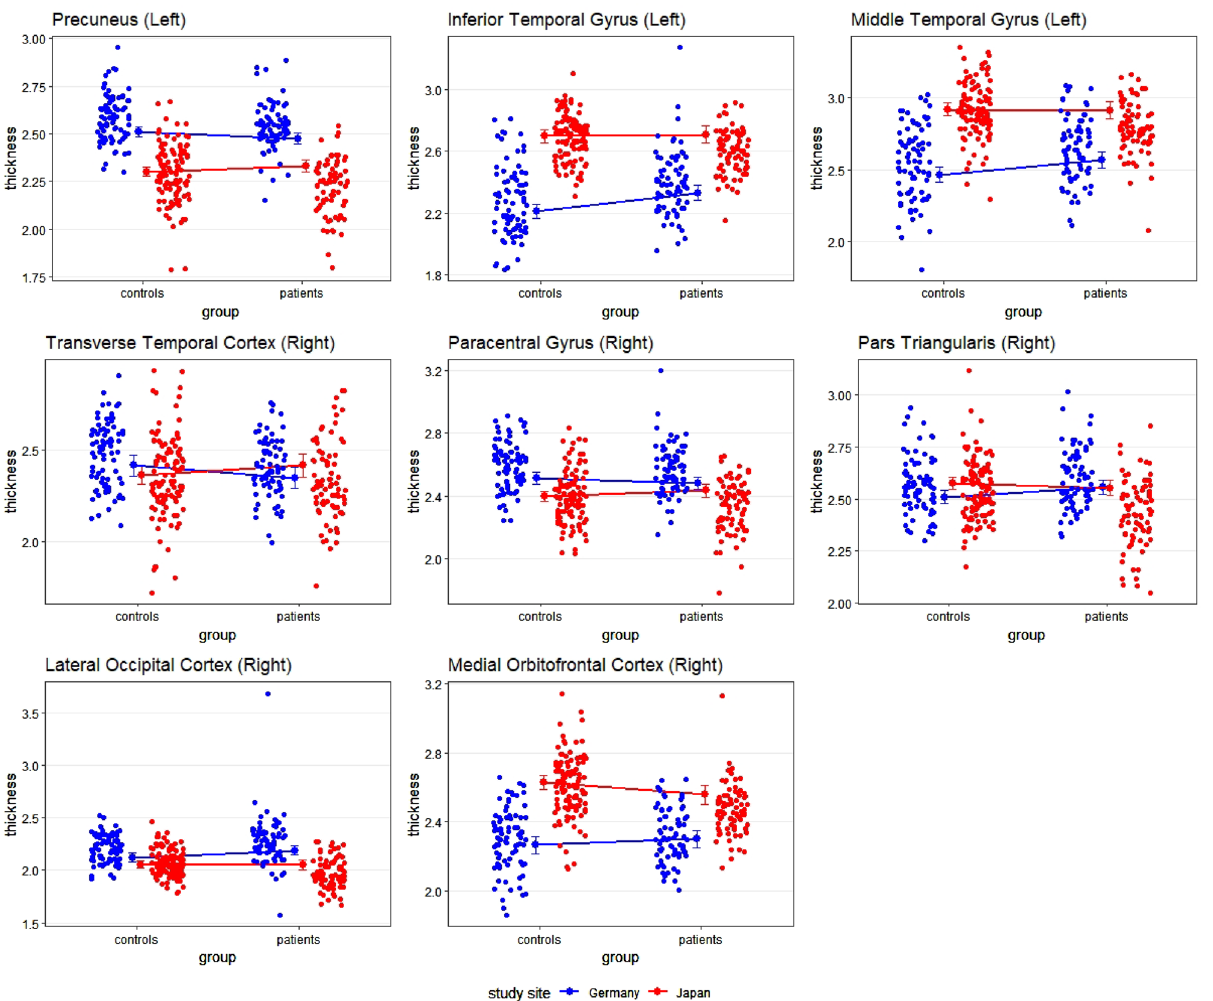
Figure 1. Scatterplots depicting the interaction between group and site with cortical thickness as dependent variable. The small dots represent the individual values per participant; the lines connect the estimated means (i.e., the output of the regression). Error bars indicate the 99% confidence